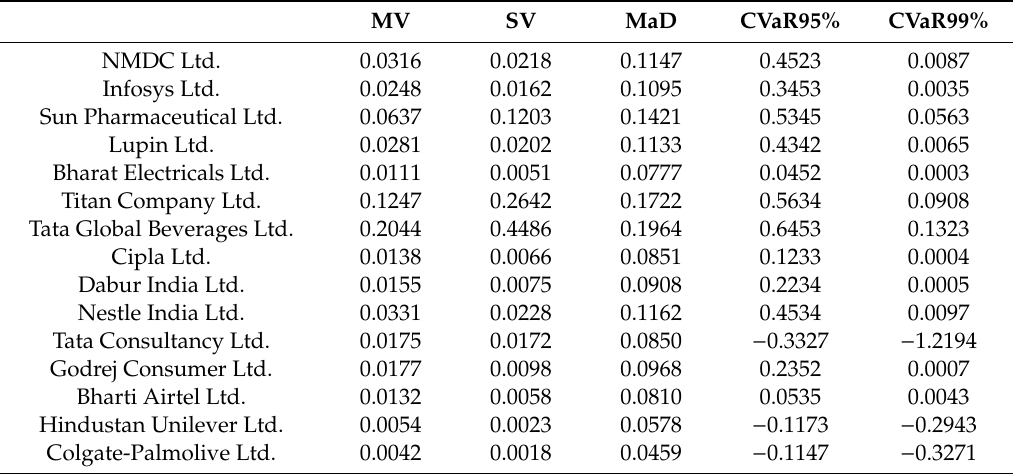
Table 8. Optimal portfolio compositions for economic recovery